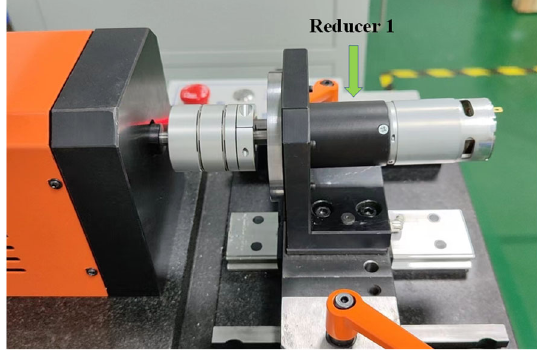
Figure 14. Clamping state of reducer 1.